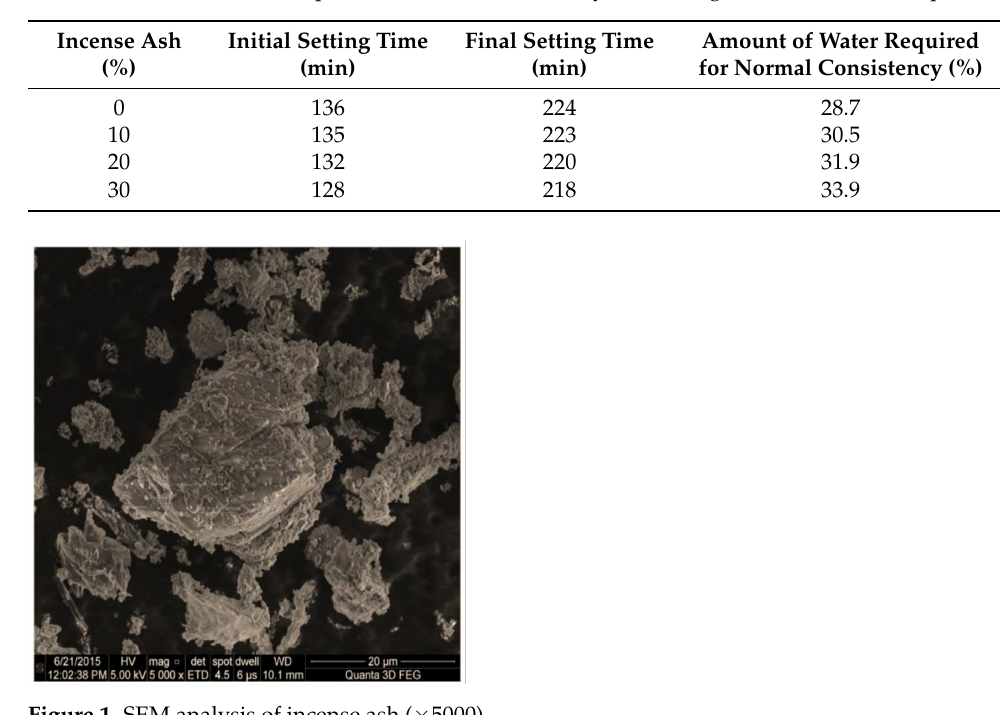
Table 2. Amount of water required for normal consistency and setting times of incense ash paste.